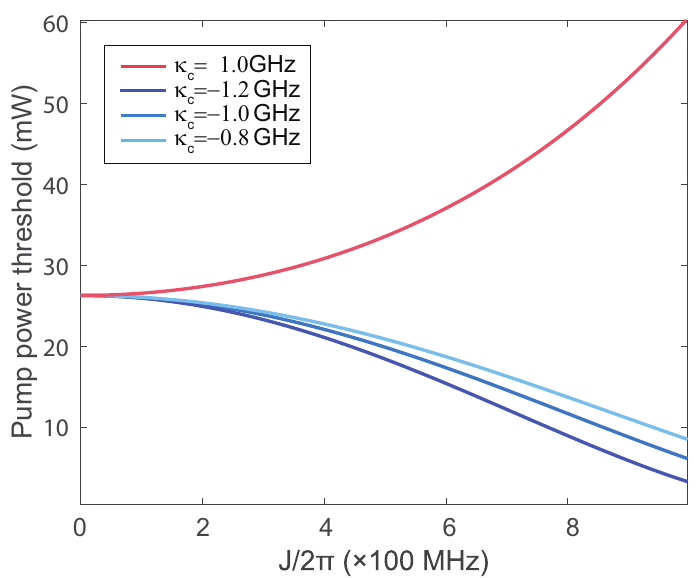
Figure 2. The pump threshold ( P th ) of the optical parametric oscillation as a function of the coupling strength ( J ) between the micro-resonators, and the parameter are chosen to be δ a /2 π = 0, δ b /2 π = 0, δ c /2 π = 0, κ a = 1.92 GHz, κ b = 480 MHz, κ a ,1 = 960 MHz, and g = 80 kHz. The dark blue line, blue line, and light blue line represent the gain rate of mode c is κ c = − 1.2, − 1, − 0.8 GHz, respectively. The red line represents the dissipation rate of mode c is κ c = 1 GHz.